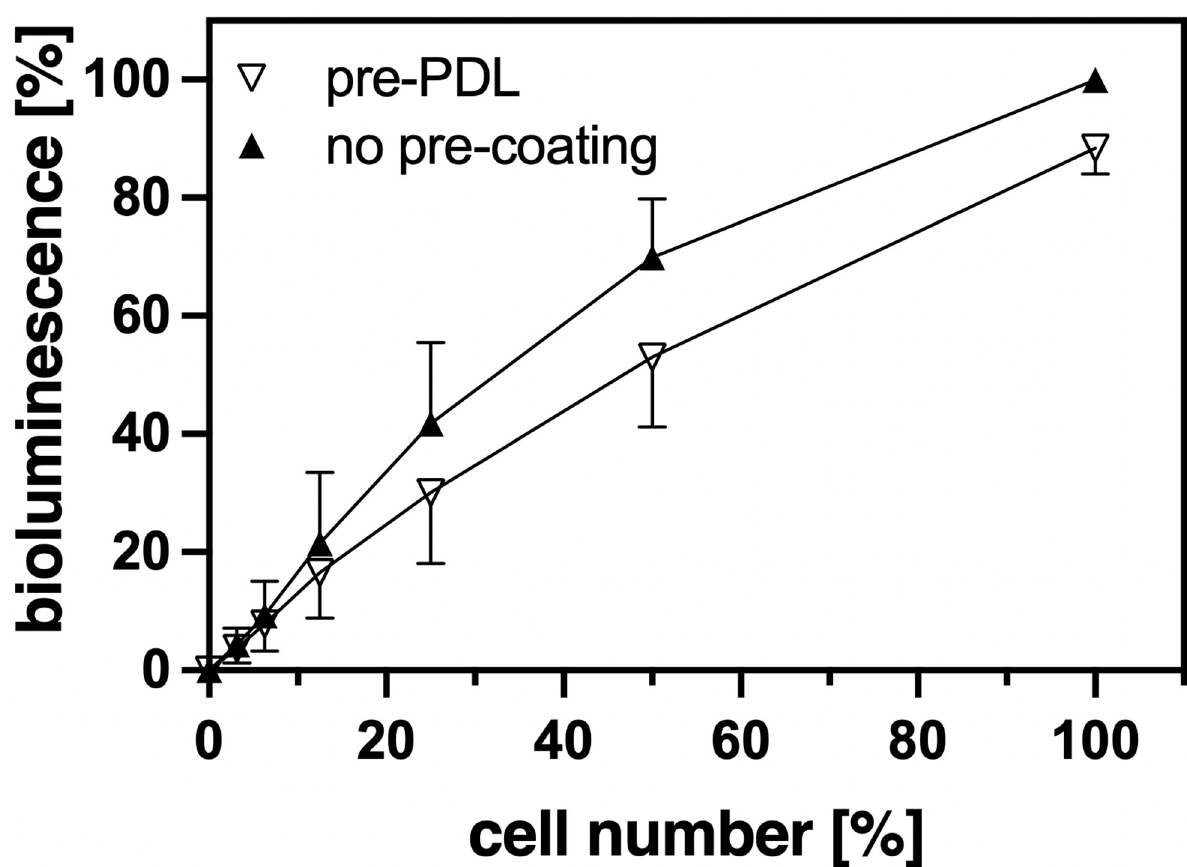
Fig 1. Correlation between cell density and measured bioluminescence with and without PDL-pre-coating. Cells expressing either GPR55- or B 2 R R128A-RlucII fusion proteins were diluted serially two-fold starting with approx. 30.000 cells per well. The wells were either pre-coated or not with PDL (100 μ g/ml, 1 h incubation). After 2–3 d, when the wells with the highest cell number had reached confluency, bioluminescence was determined as described in “Materials and methods”. The confluent wells without pre-coating were taken as 100%. Results are presented as Mean ± SD (number n of independent experiments = 5, performed in